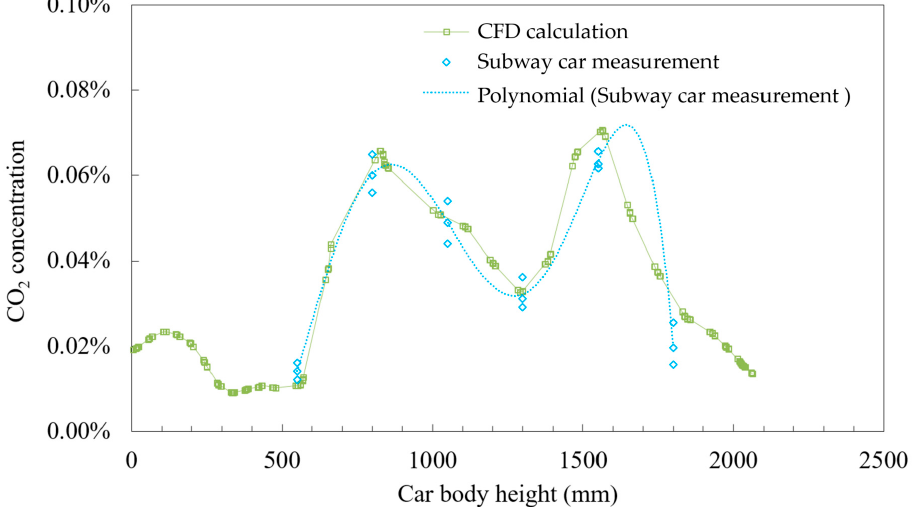
Figure 3. Comparison of the results of the subway car experiment and CFD test results.